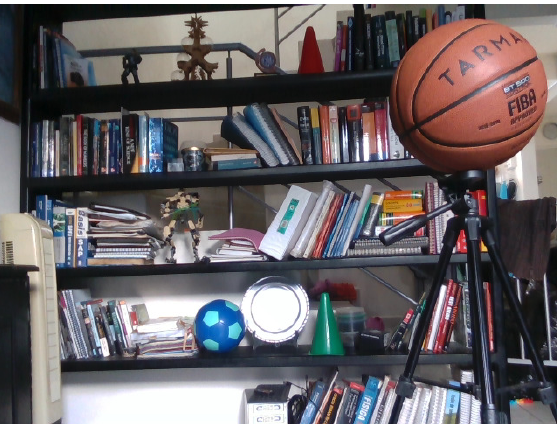
Figure 14. Color scene showing details of the third experiment considering a new position of the ball in scene. A difference in depth is observed with respect to the second experiment (Figure 15).